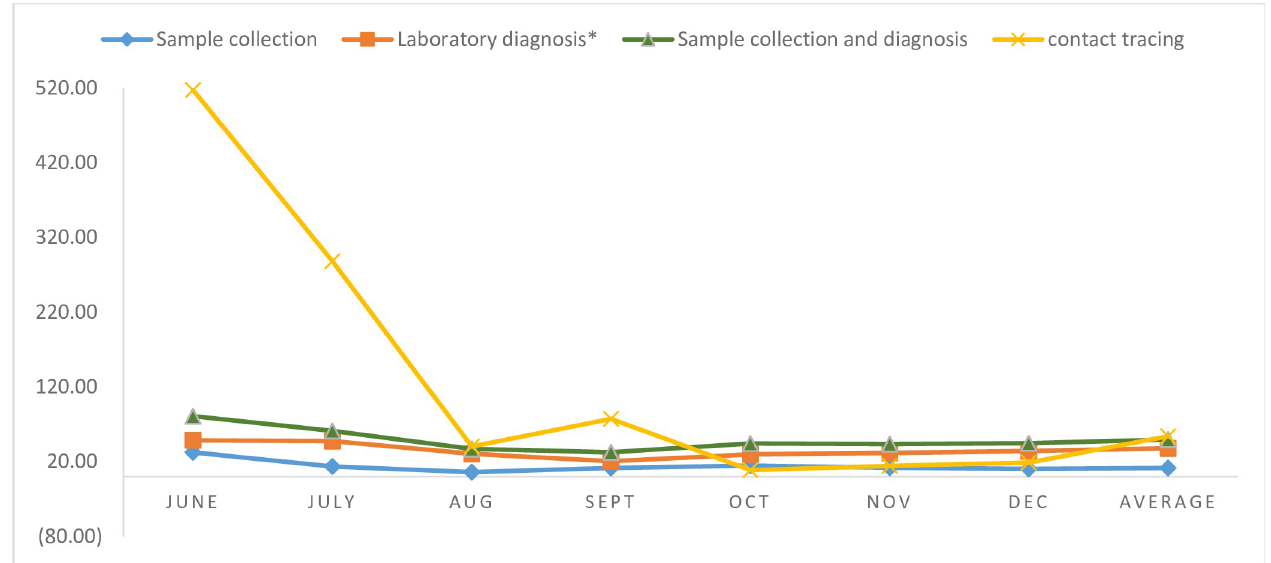
Fig 3. Unit cost of sample collection and laboratory diagnosis to identify COVID-19 positive cases. � Laboratory diagnosis cost only includes the cost after receiving the COVID-19 samples.